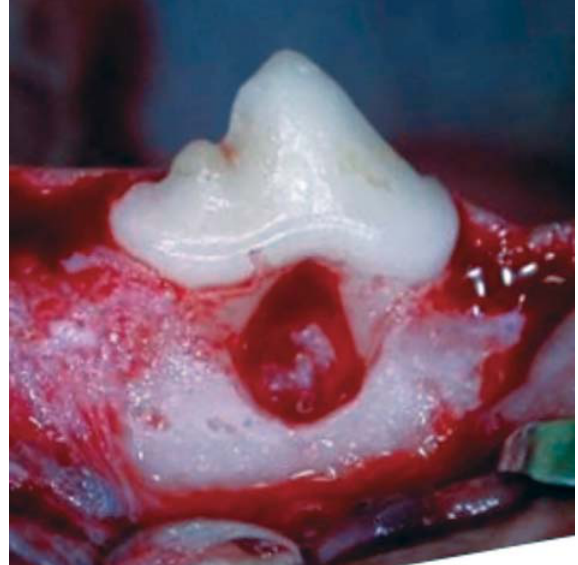
Figure 1- Clinical aspect of Class II furcation defect (5x 2 mm)